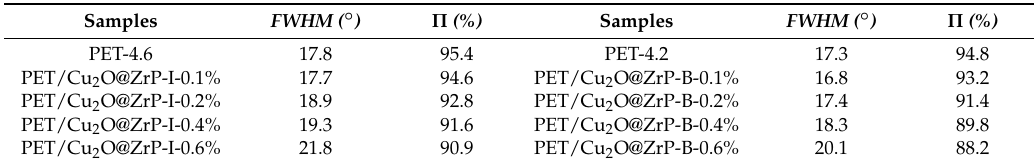
Table 1. Data of the full width at half maximum ( FWHM ) and preferential orientation ( Π ) based on Figure 5.